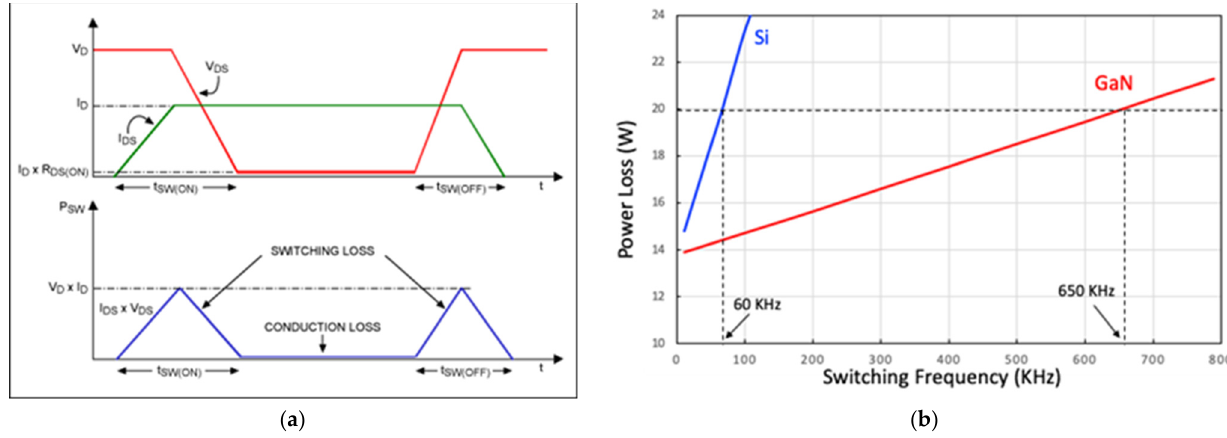
Figure 6. ( a ) Relation between switching speed and energy loss for a power switch, and ( b ) the lower power loss of GaN compared with Si [40]. Figure reproduced with permission from IEEE 2016 10th International Conference on Compatibility, Power Electronics and Power Engineering .